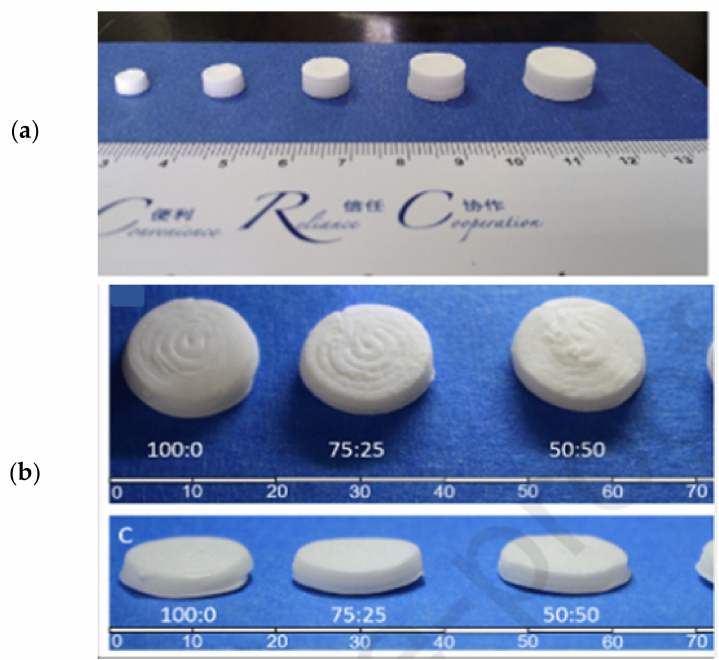
Figure 14. Dried 3D-printed levetiracetam tablets ( a ) and theophylline tablets ( b ) solidified at room temperature. Images reproduced with permission from [58,59]. Copyright Elsevier, 2021 & 2019.